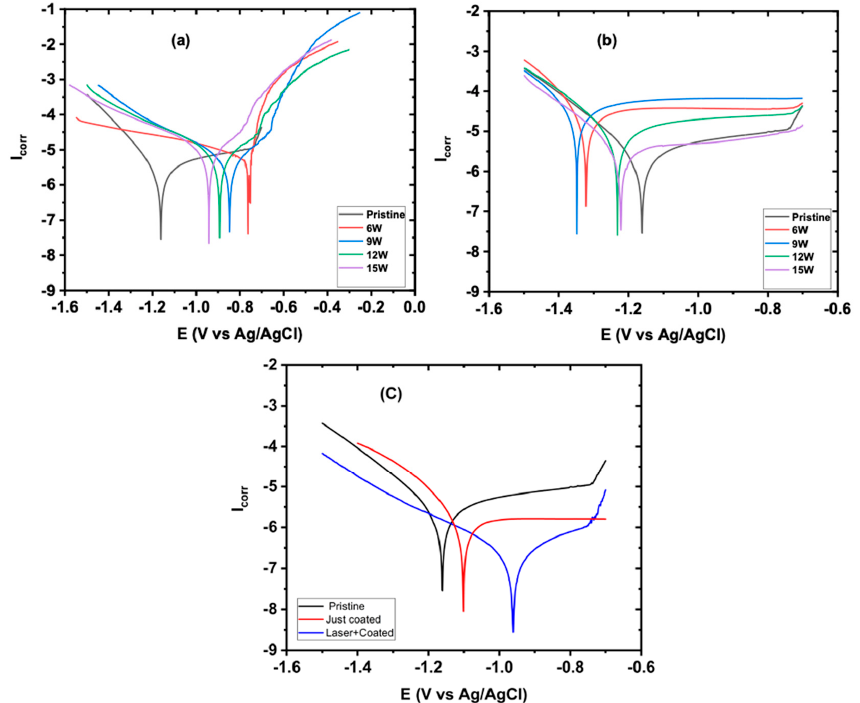
Figure 8. Tafel plots of ( a ) laser-treated and annealed samples, ( b ) just laser-treated samples, and ( c ) a comparison of the pristine, the only Mo-coated, and the laser-structured and Mo-coated samples. Though the annealing process induced passivation in the laser-treated samples by shifting the E corr during Tafel polarization in the positive direction, the minimal change in I corr suggested a genuine need for a protective coating to improve the corrosion inhibition efficiency. Figure 8c shows the Tafel plots for the coated sample without structuring and the laser-structured and annealed Al 6061 samples coated with Mo by the fs-PLD process. As shown in Figure 8c, the just-coated sample exhibited an I corr value of 0.89 µA/cm 2 (com- pared to pristine sample of 1.93 µA/cm 2 ) and showed a corrosion inhibition efficiency (CIE) of 53%. To further improve the CIE, the sample was laser treated prior to coating. This step induced a layer of oxides on the sample surface and then annealing. As a result, a thick passive layer of oxides of aluminum (as supported by EDS and XRD) was formed on the surface. These samples were then coated with Mo using the fs-PLD process. The laser and coated (L + C) sample exhibited an I corr value of 0.316 µA/cm 2 with approximately an 83% increase in the corrosion inhibition efficiency (CIE), as calculated from Equation (1): 𝐶𝐼𝐸% (cid:3404) (cid:3010) (cid:3278)(cid:3290)(cid:3293)(cid:3293) (cid:2879)(cid:3010)(cid:4593) (cid:3278)(cid:3290)(cid:3293)(cid:3293) (cid:3010) (cid:3278)(cid:3290)(cid:3293)(cid:3293) × 100 (1) where I corr and I’ corr are the corrosion current densities before and after, respectively, the surface modifications and coating. From Ohm’s law, I corr = E/R p , where E is the potential difference between the cathode and anode on the potentiodynamic curve; R p is the polarization resistance, which is the sum of the electric resistance of the corrosive solution (R s ) and the charge transfer re- sistance of the working electrode (R ct ). For the laser-treated and coated sample, the R ct was modulated by the thick layer of the Mo coating along with the oxide layer of the substrate material surface induced using the femtosecond laser, while for the just-coated sample,